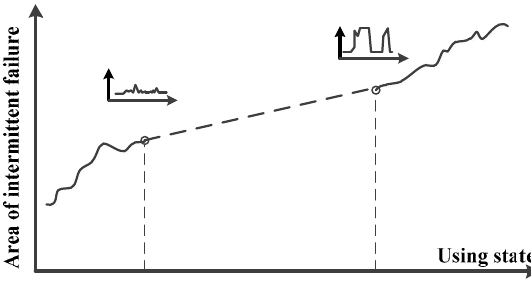
Figure 5. The “severity” of intermittent failure increases with the degradation of the using state.